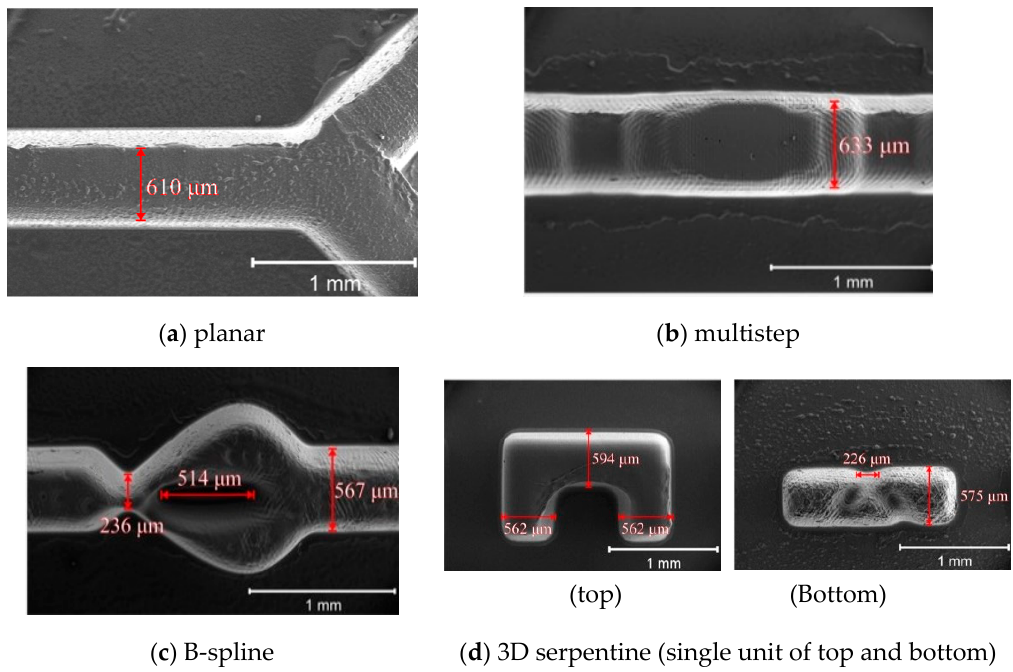
Figure 10. Top view SEM images of micromixers; from top and in clockwise direction: ( a ) planar, ( b ) multistep, ( c ) B-spline and ( d ) 3D serpentine (top and bottom).